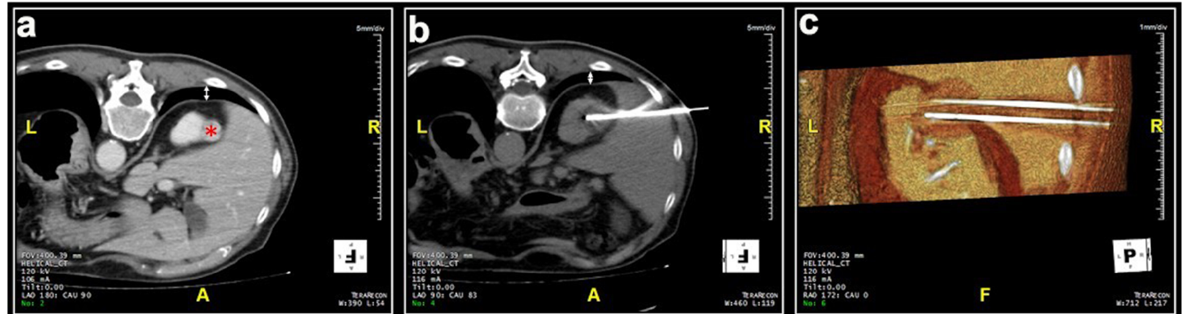
Figure 3. Male, 78 years old. ( a ) The initial scan shows a lesion (*) located at the upper pole of the right kidney covered by the costophrenic sinus posteriorly (white arrow) and the hepatic parenchyma laterally. ( b , c ) The lesion was adequately treated with two cryoprobes inserted through the hepatic parenchyma in order to avoid pneumothorax. No complications